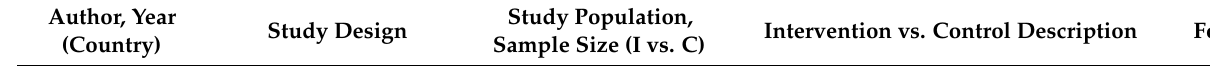
Table 1. Study characteristics ( n = 18